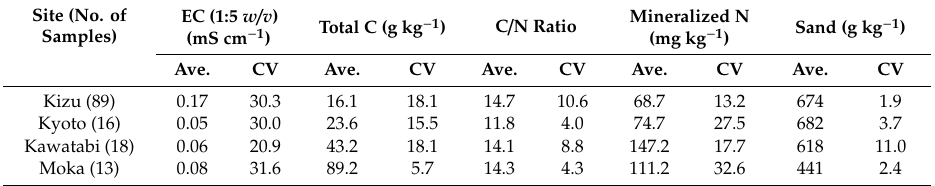
Table 1. Selected properties of the samples used in this